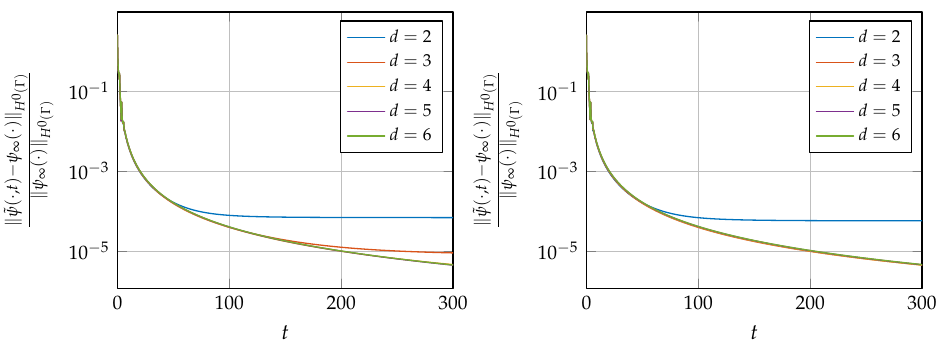
Figure 18. Time history of the relative error between transient and stationary solution in H 0 ( Γ ) norm for increasing degrees of B-spline (left) and Lagrangian (right) shape functions on a uniform spatial discretization of size ∆ x = 0.1. The time interval [ 0, T ] = [ 0,300 ] has been decomposed into 1500 time steps of size ∆ t = 0.2.